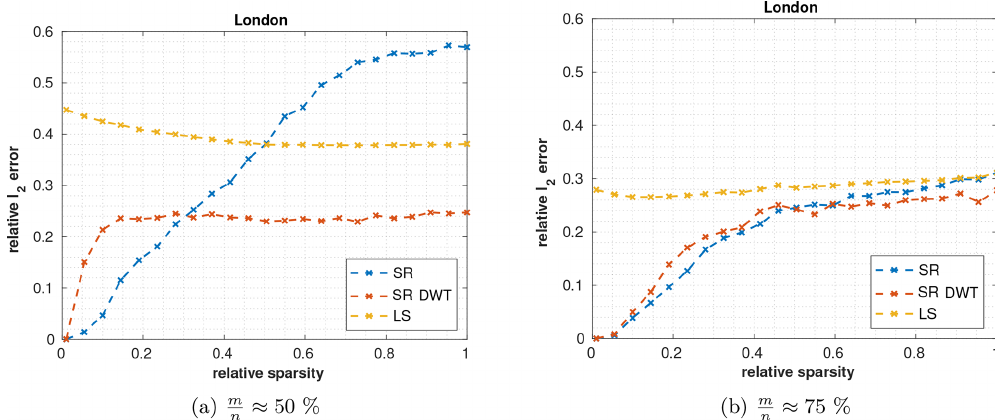
Figure 6. Comparison of the LS (yellow) and SR in the spatial (blue) and wavelet (red) domains in terms of relative sparsity s rel . An emission map artificially generated from London’s emission inventory with a total of 2205 unknown emitters was used. The x axis represents the portion of these emitters that were used (the emitters are sorted from large to small). In (a) 22 measurement stations with a total of 1100 measurements and (b) 33 measurement stations with a total of 1650 measurements are